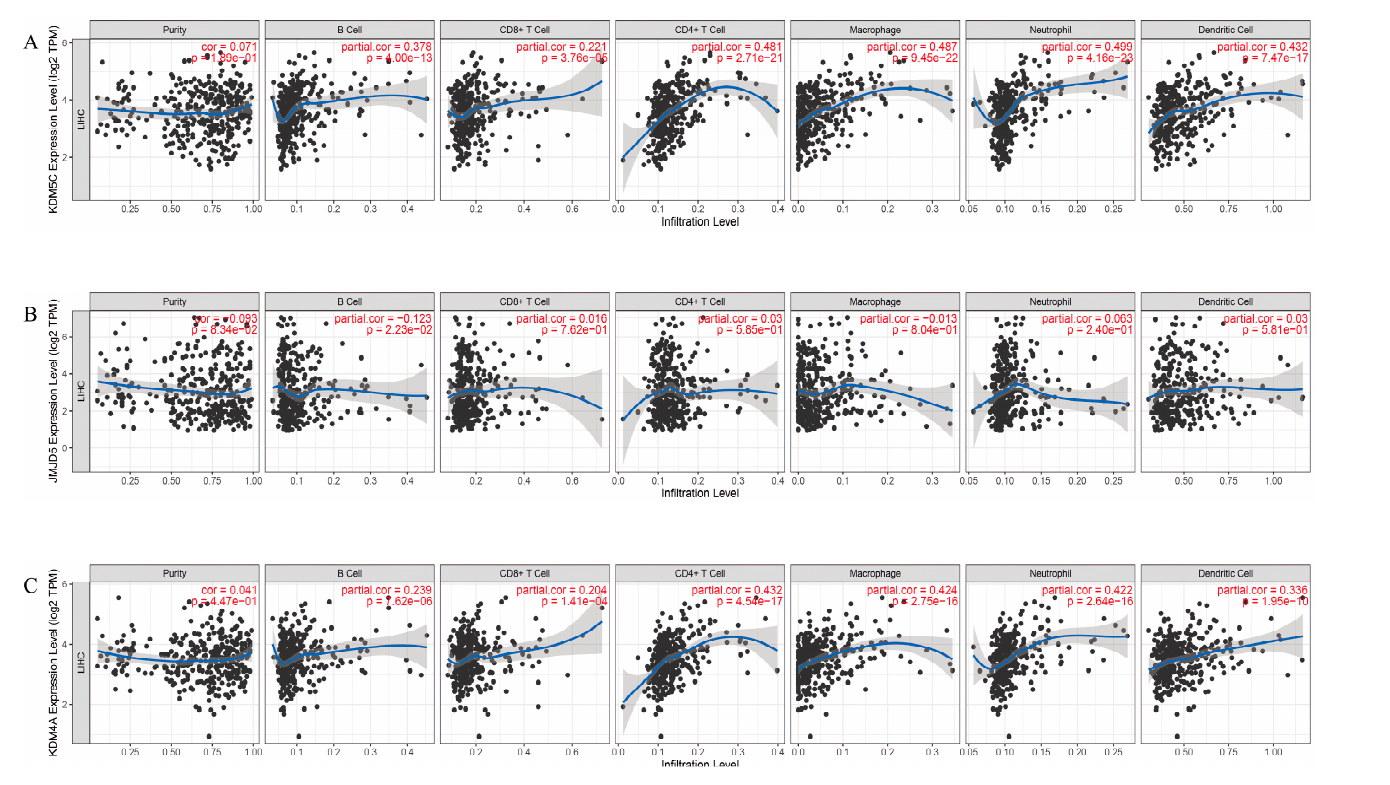
Figure 7. Association of KDM5C, KDM8, and KDM4A with immune cell infiltration in the TIMER database. ( A ) KDM5C. ( B ) KDM8. ( C ) KDM4A. Abbreviations: TPM, Transcripts Per Million; LIHC, liver hepatocellular carcinoma.